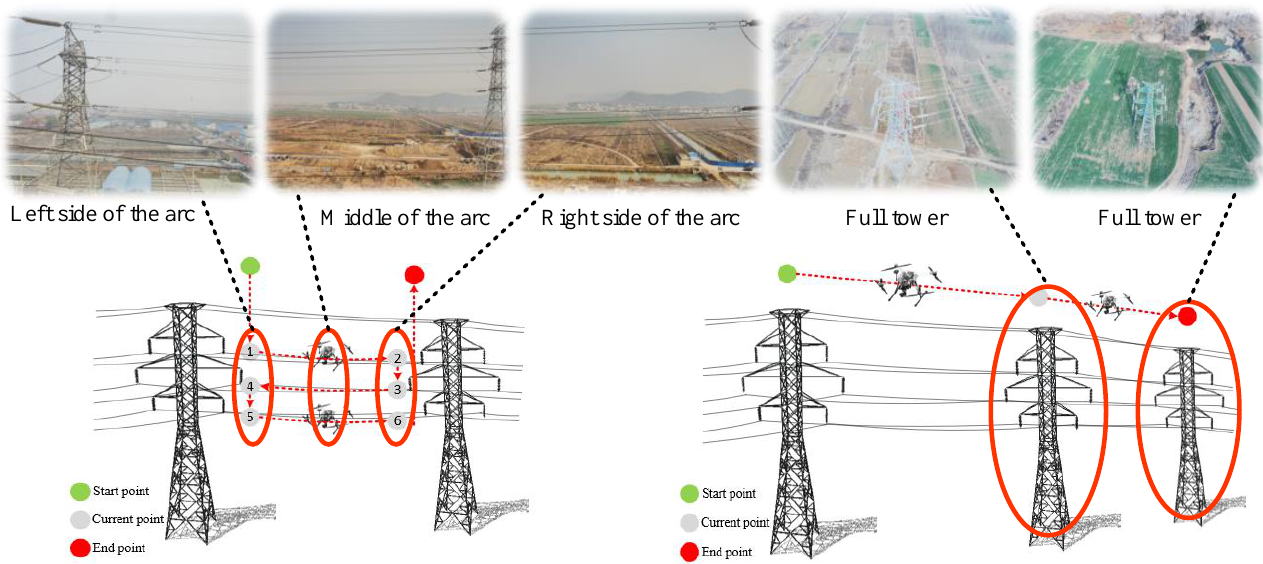
Figure 14. Arc-chasing inspection and channel inspection task data